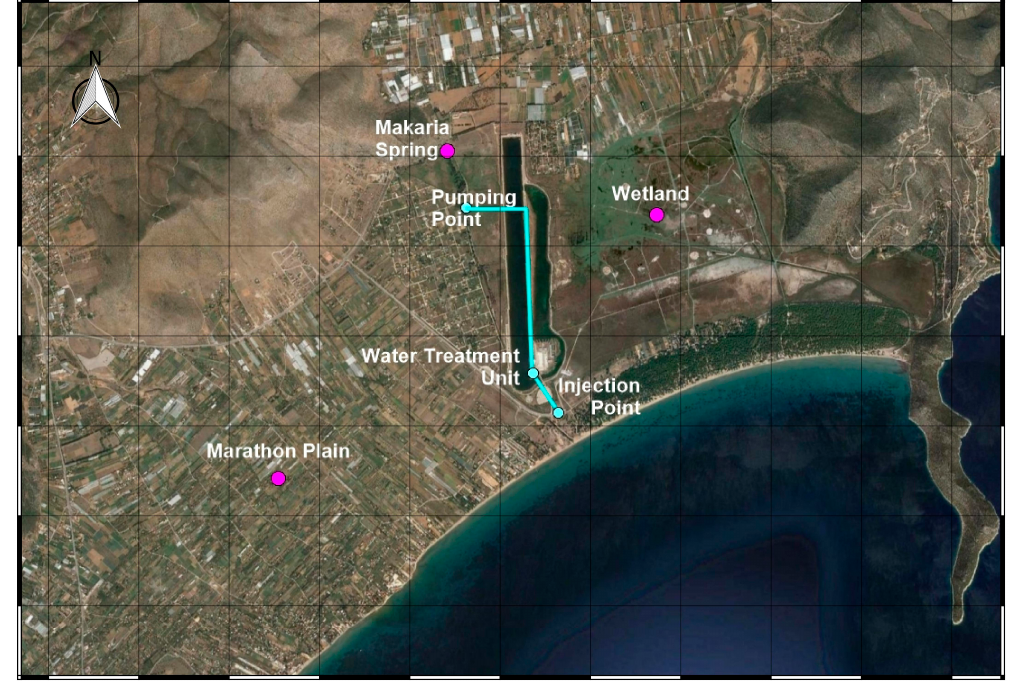
Figure 4. Experimental setup of a SWS in Schinias, Marathon plain.